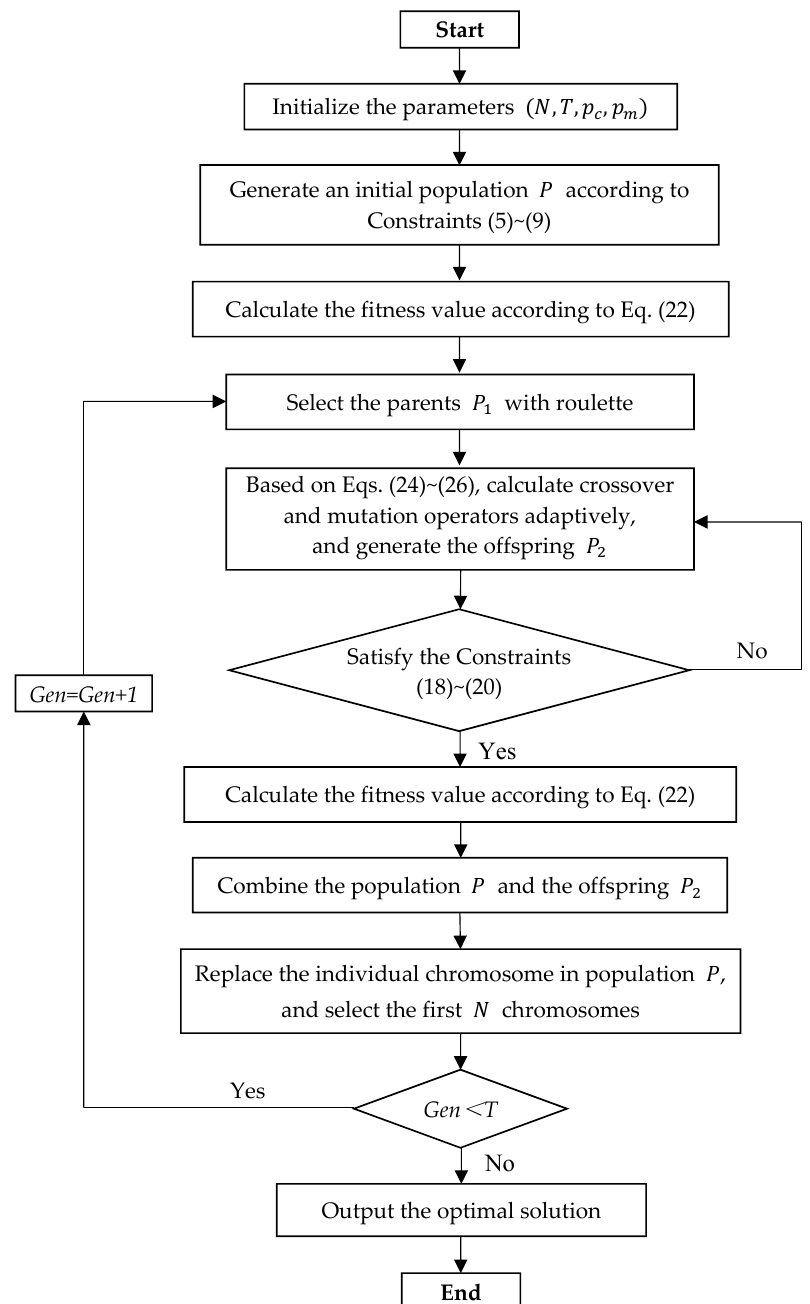
Figure 2. Flow chart of genetic algorithm with adaptive operators (GAAO).